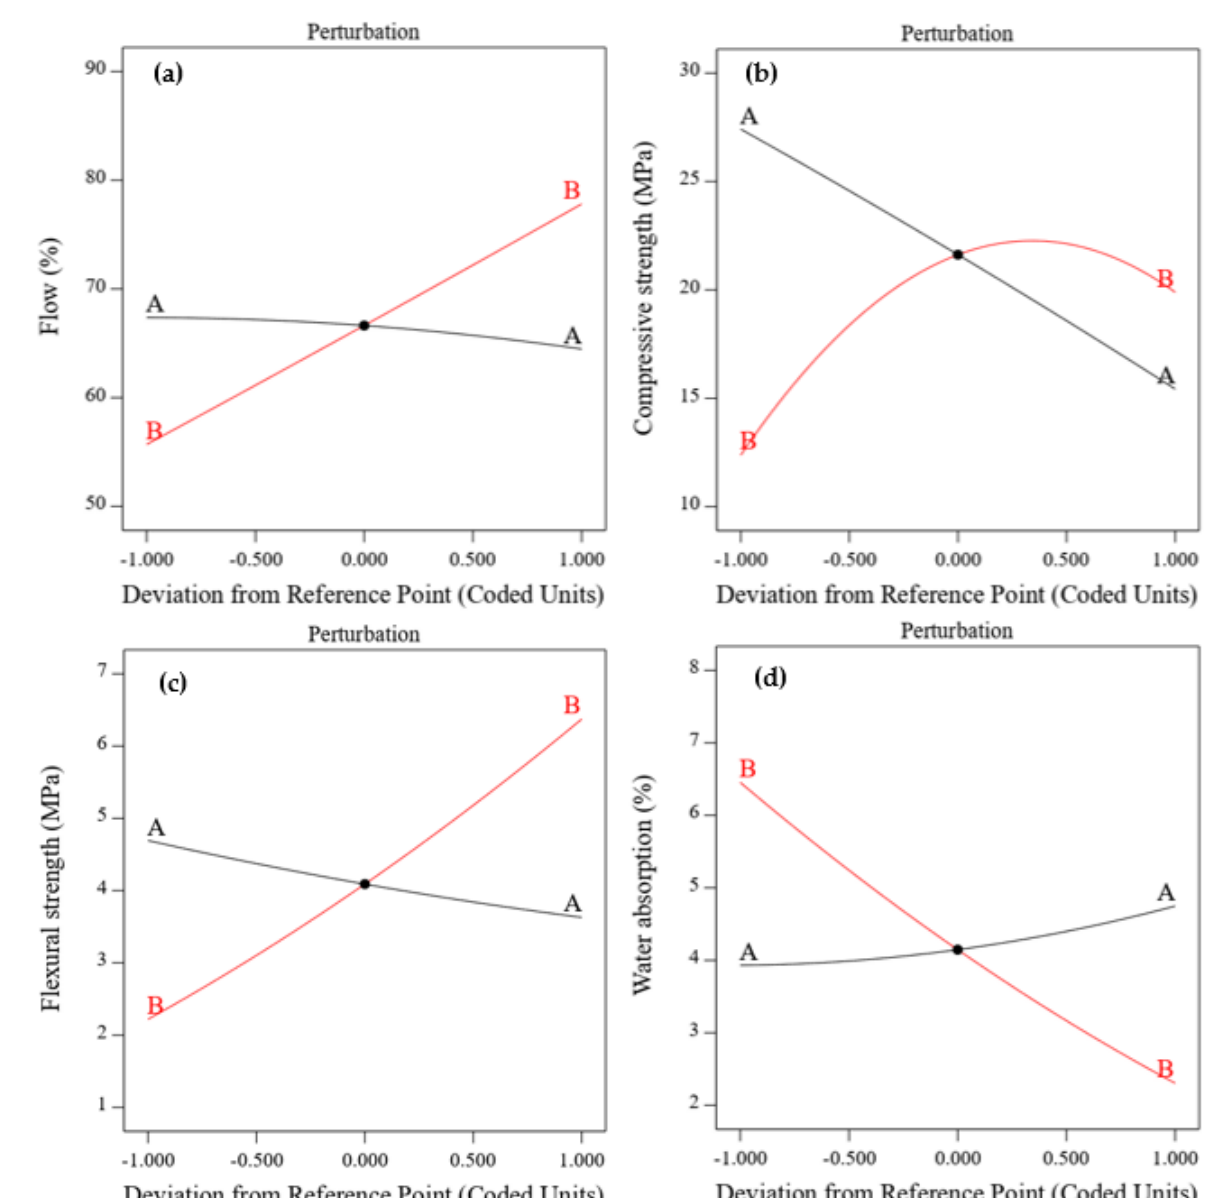
Figure 10. Perturbation plots of ( a ) flow, ( b ) compressive strength, ( c ) flexural strength, and ( d ) water absorption.